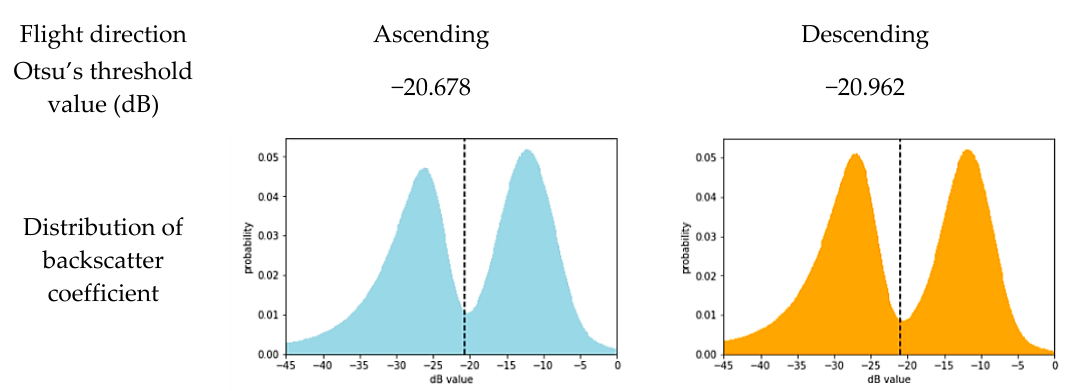
Figure 4. The distributions of the backscatter coefficient and the decided Otsu’s threshold values of the ascending and descending Sentinel-1 SAR imagery for the Lake Urmia waterbody classification.